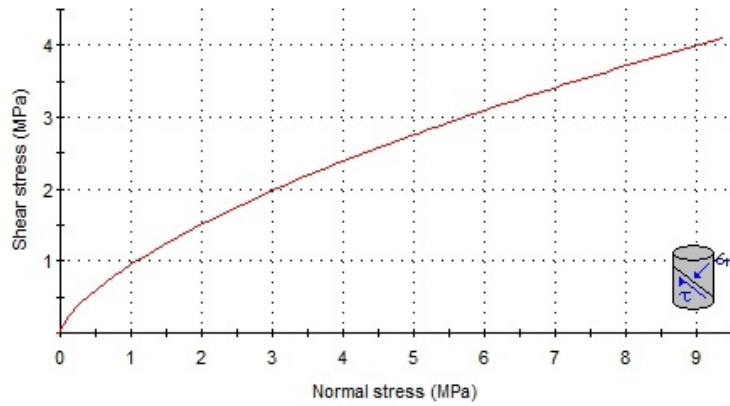
Figure 5. Estimated value shear stress–normal stress for carbonate siltstone.